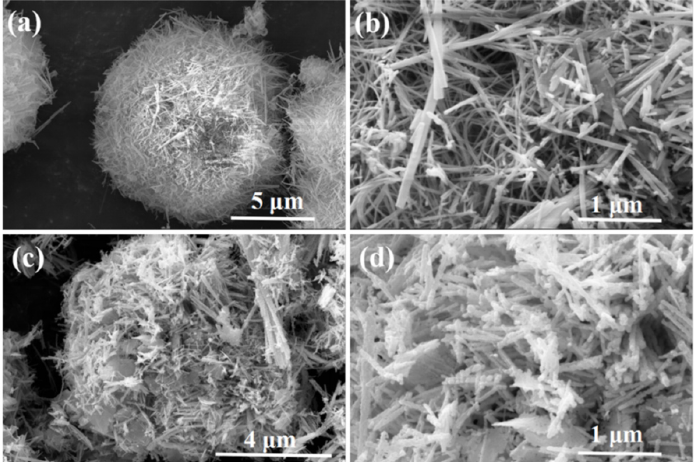
Figure 1. Low magnification scanning electron microscopy (SEM) images of NiCo 2 O 4 ( a ) before and ( c ) after annealing at 700 °C; and high magnification SEM images of NiCo 2 O 4 ( b ) before and ( d ) after annealing at 700 °C.